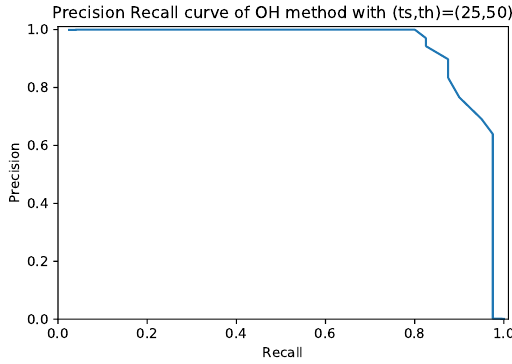
Figure 5. Comparison in performances between the multidate and monodate method. In blue, the ROC curve of the multidate method. In green, the ROC curve of the monodate one. Each point is obtained by thresholding the NFA map with a different value ϵ . In orange, the performance of a pure random classifier.